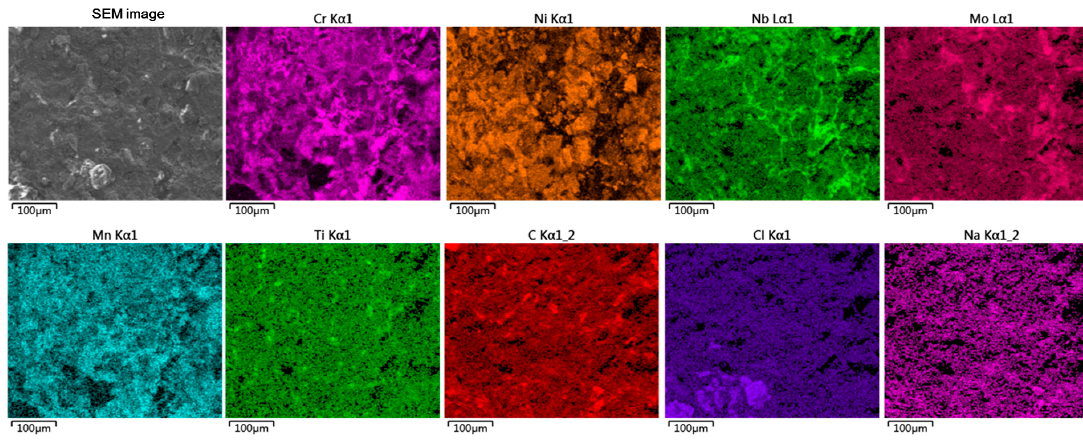
Figure 9. The surface analysis of sample #4 based on the EDS mapping.